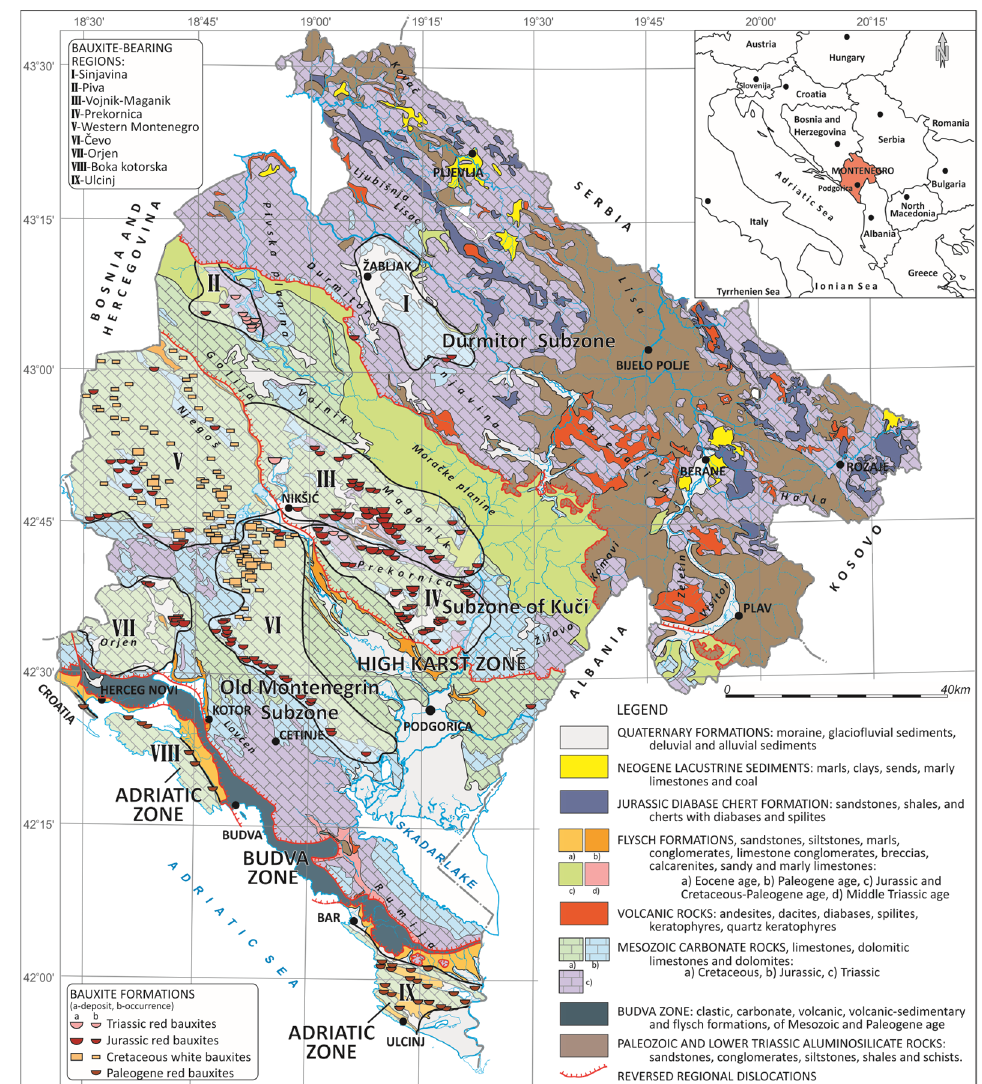
Figure 1. Geological map of Montenegro (after Mirkovi ć , et al., modified [63]), with bauxite-bearing regions, bauxite formations, deposits and occurrences of karstic bauxites (after Pajovi ć [15]). The territory of Montenegro is built of different types of sedimentary, igneous and metamorphic rocks. Most of the terrain is built by Mesozoic formations of carbonate composition. They are developed in the northern, central and coastal part of